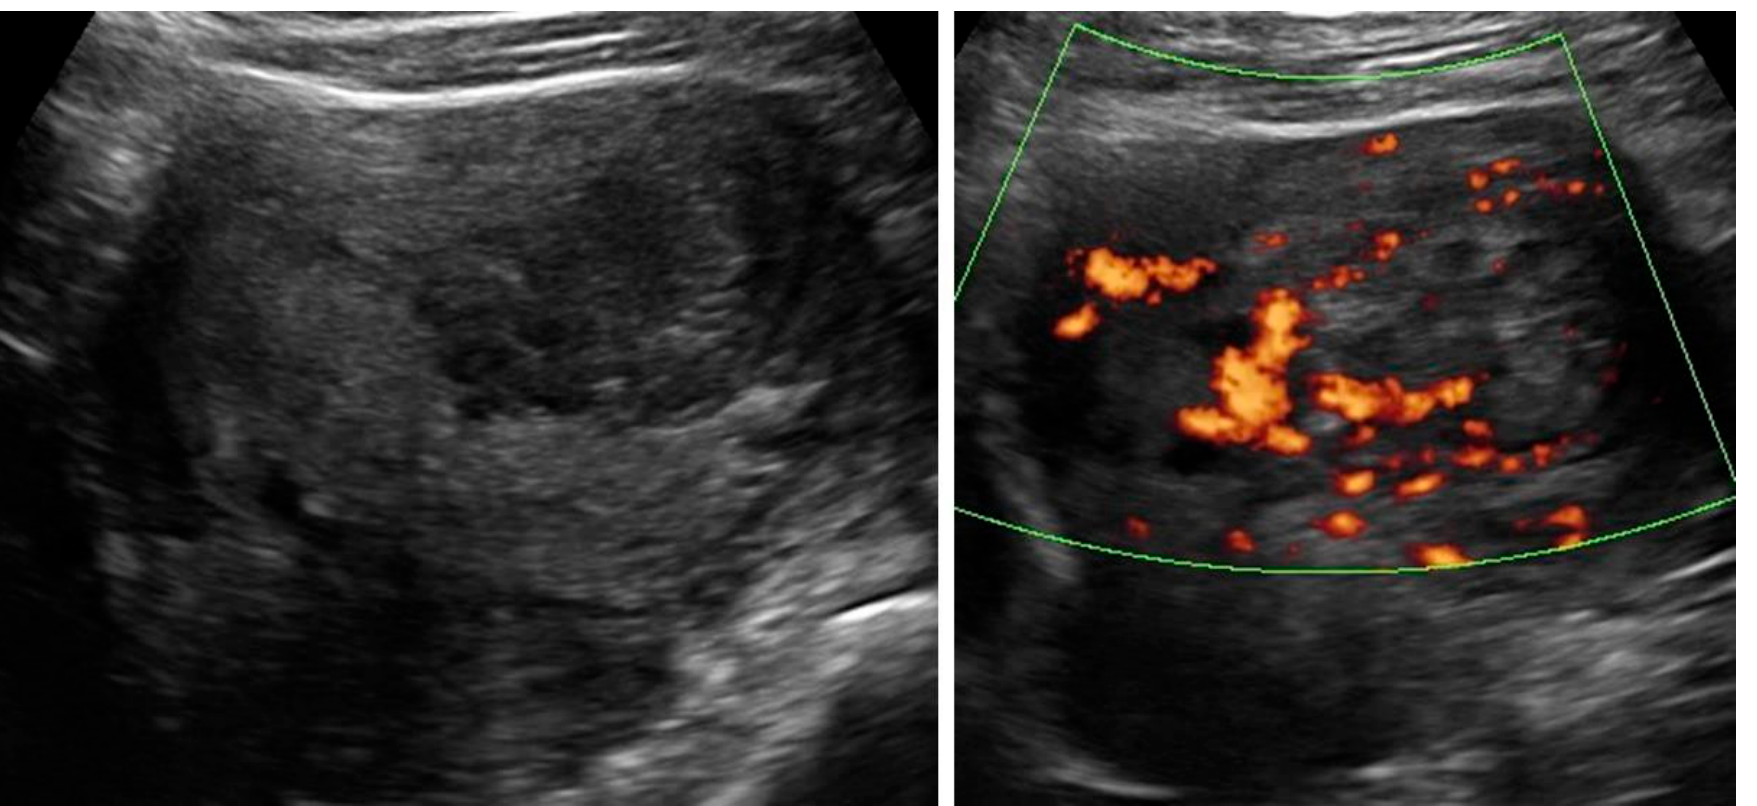
Figure A7. Transabdominal ultrasonogram (convex probe) of the uterine lesion (atypical) in the myometrium, B mode and Doppler. Histology: leiomyoma with signs of degenerations .